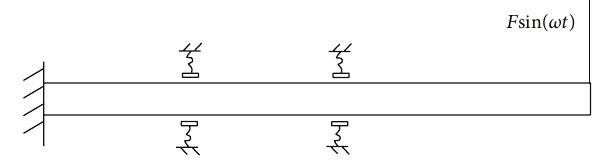
Figure 1: Nonlinear system with linear impact forces at two points and harmonic excitation at 𝑥 = 𝐿 .